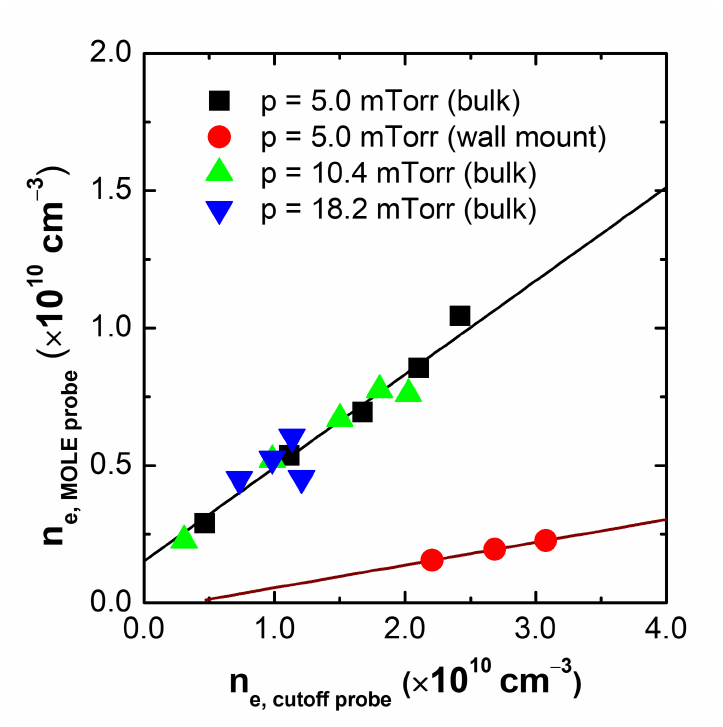
Figure 10. Estimated electron density from the MOLE probe ( n e,MOLEprobe ) at the bulk and on the wall over densities from the cutoff probe ( n e,cutoffprobe ) at various